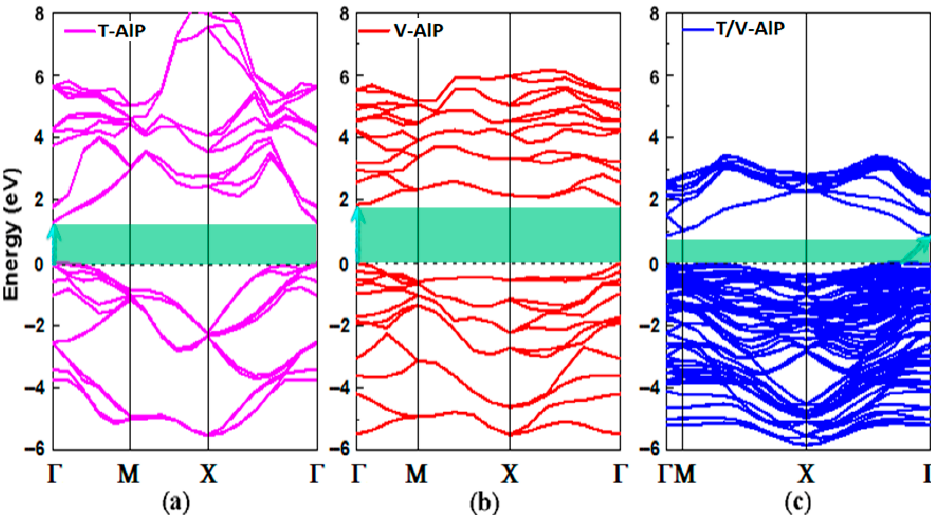
Figure 3. Energy band structures of T-AlP, V-AlP and T/V-AlP bilayers. In ( a ) and ( b ), the vertical arrows represent the direct band gaps of T-AlP and V-AlP materials, and the diagonal arrow in ( c ) represents indirect band gap of the T/V-AlP heterojunction. The horizontal dotted line represents Femi level and the light green areas denote the bandgap.